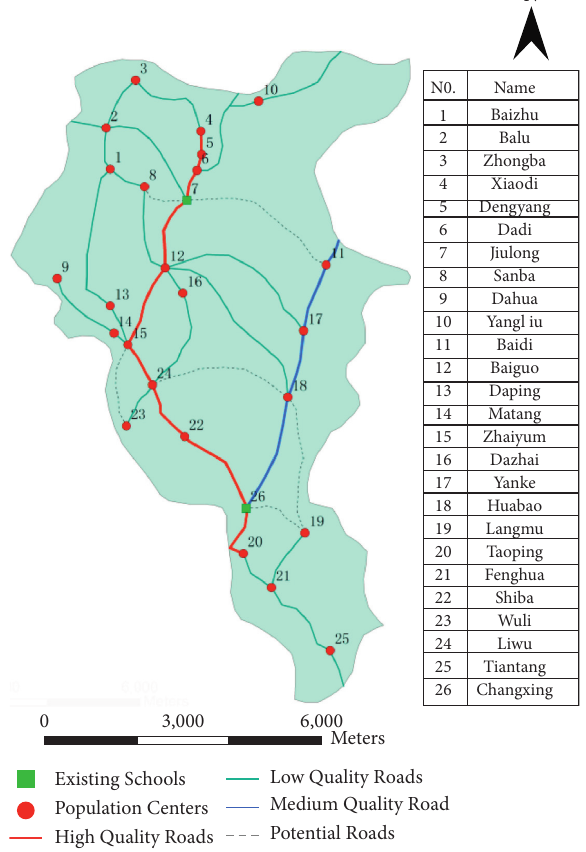
Figure 4: Map of the study area with population center and the road network. Figure 5: The optimal solution of Model